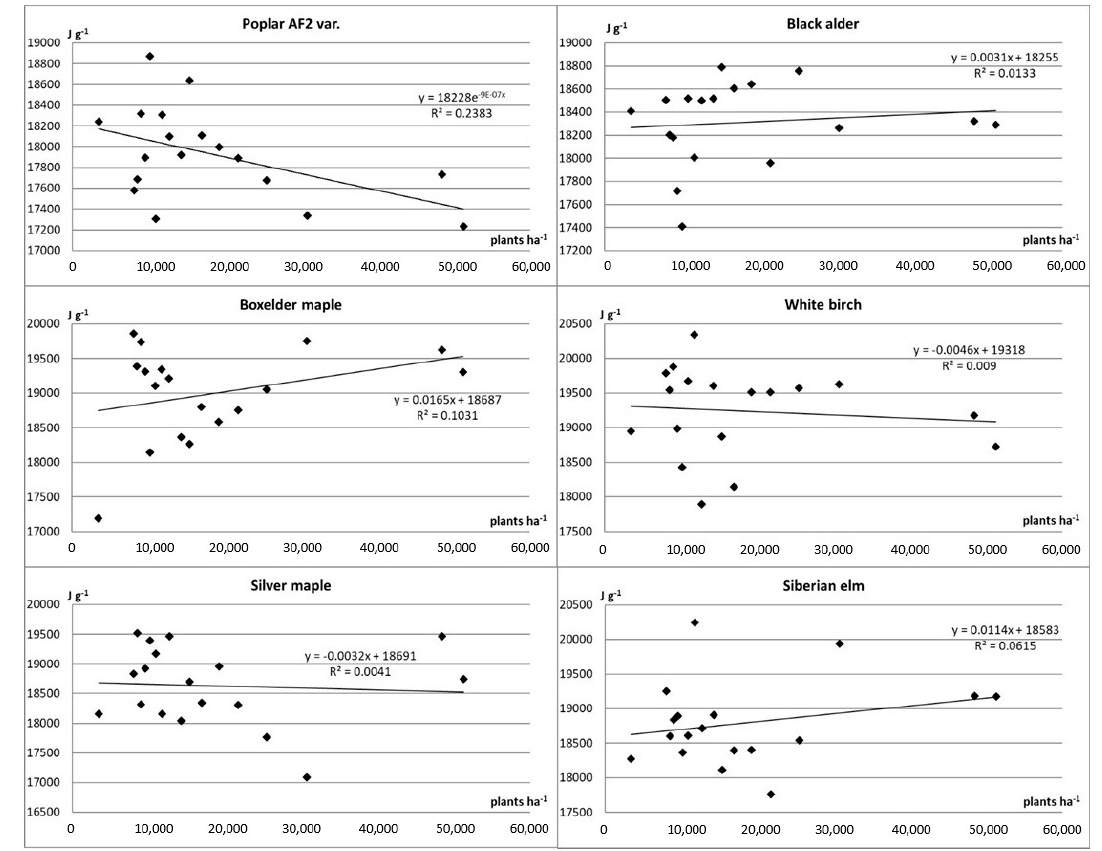
− 1 ) and planting density (plants ha − 1